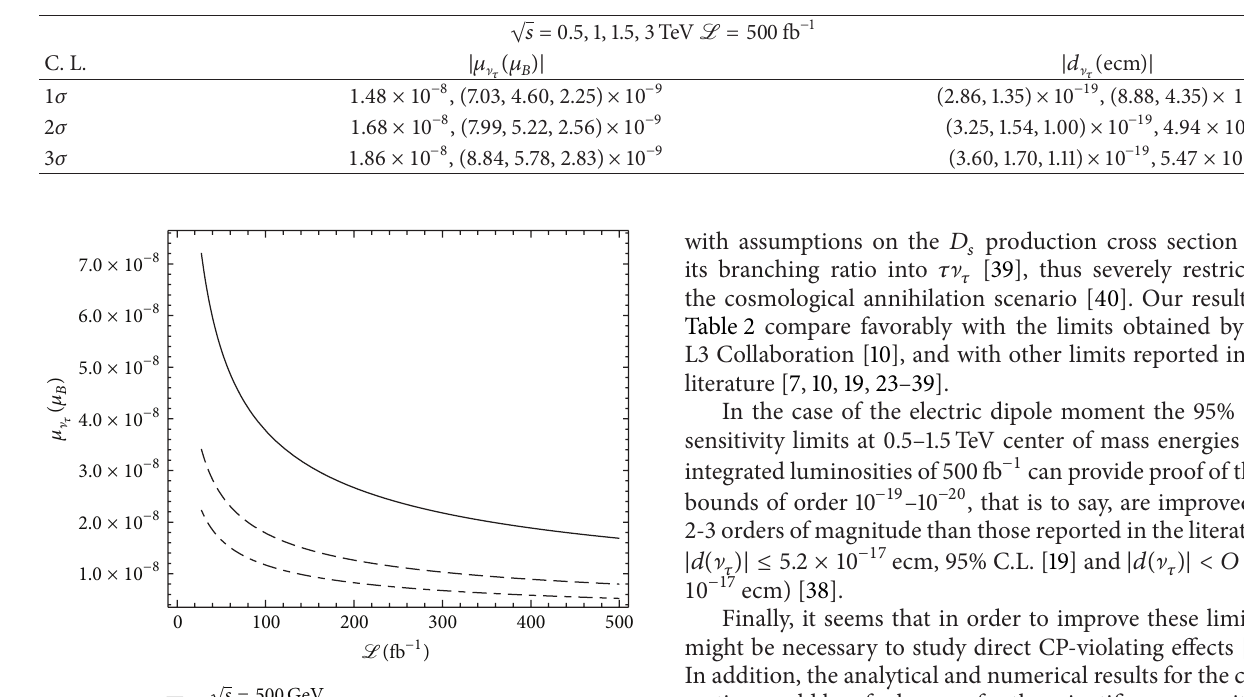
Table 2: Bounds on the 𝜇 ] magnetic moment and 𝑑 ] electric dipole moment for √𝑠 = 0.5, 1, 1.5, 3 TeV and L = 500 fb −1 at 1𝜎 , 2𝜎 , and 3𝜎 . 𝜏 𝜏